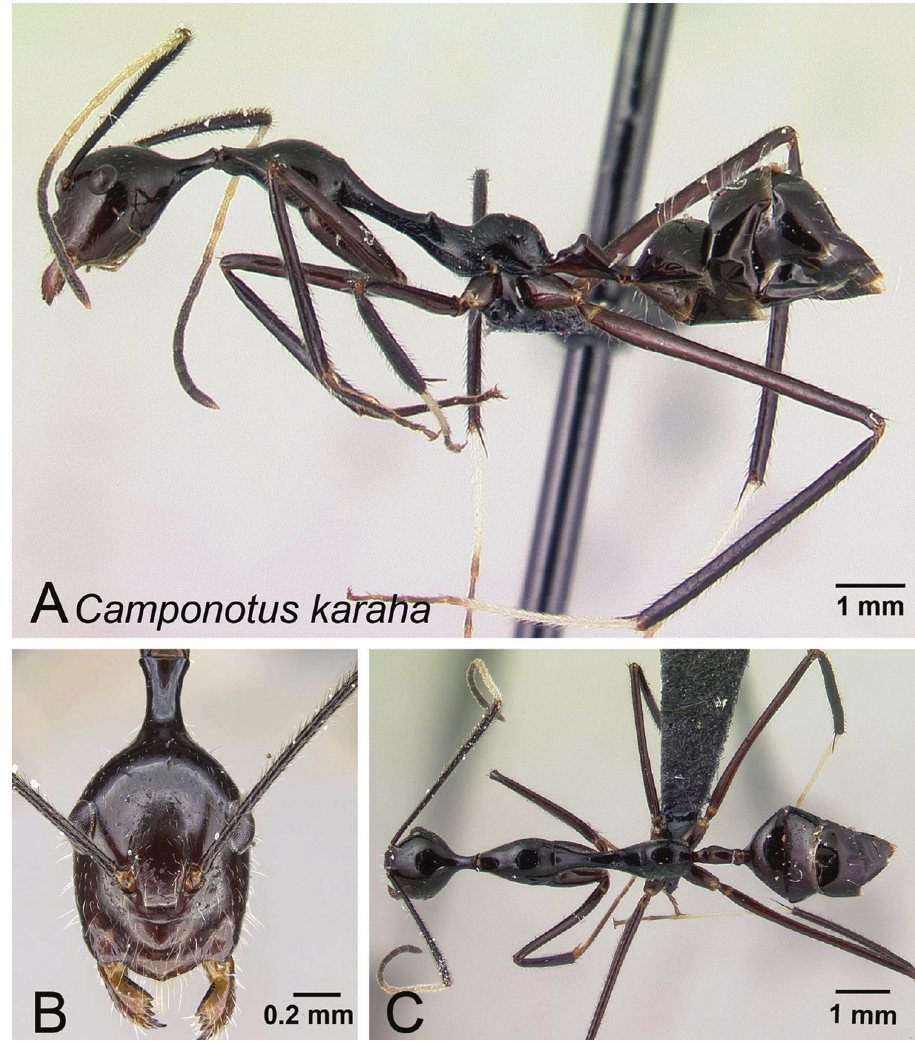
Figure 13. Camponotus karaha minor worker CASENT0067555. A Lateral view B Head in full-face view C Dorsal